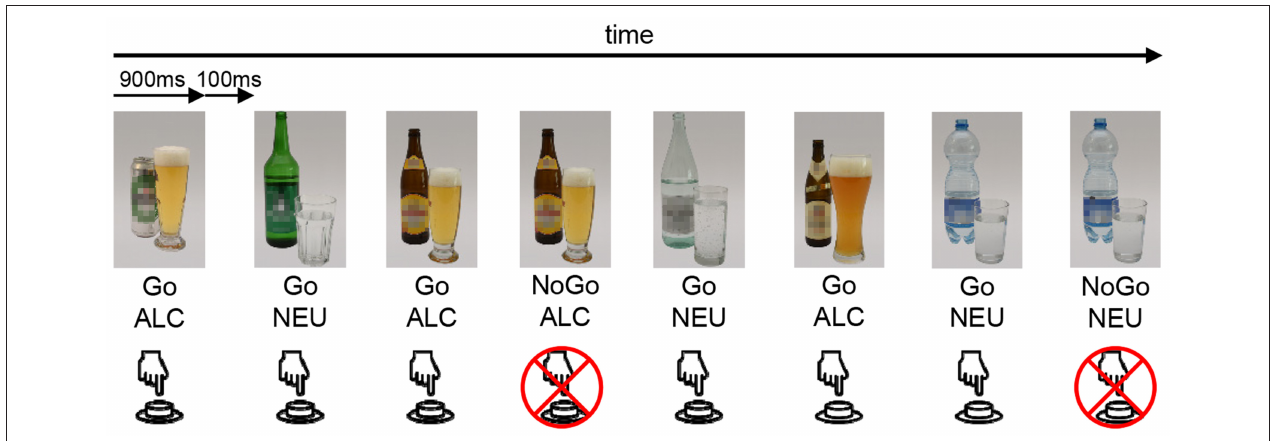
FIGURE 2 | Schematic illustration of the GNG event-related fMRI task. The stimuli are either an alcoholic bottle with a glass (ALC) or a neutral (i.e., water) bottle with a glass (NEU). This is an example of the beer set, whereas depending on the participant’s preference, also wine or spirits sets were available. Participants were instructed to press a button whenever a stimulus appeared (Go), unless the exact same stimulus was shown twice successively